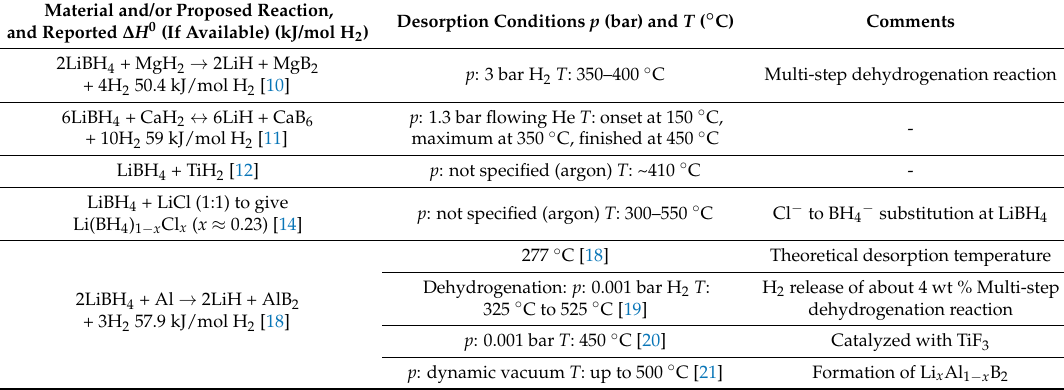
Material and/or Proposed Reaction, and Reported ∆ H 0 (If Available) (kJ/mol H 2 )